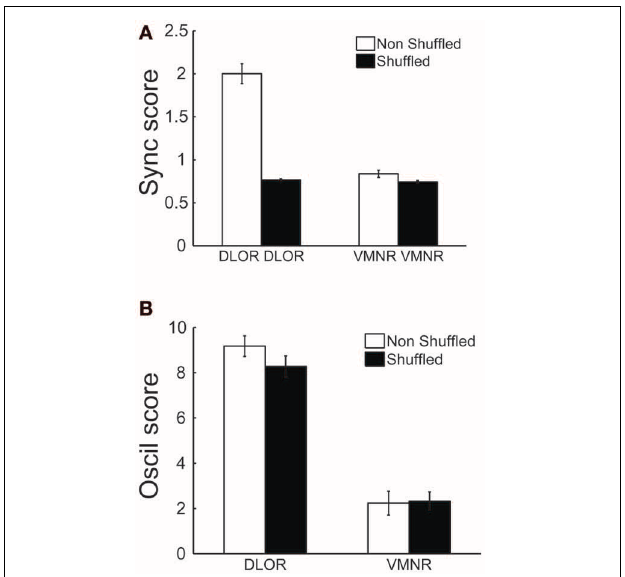
FIGURE 6 | Average values of synchronization ( sync score ) in the DLOR, but not average VMNR synchronization or oscillations scores in both STN domains, are affected by the shuffling procedures. (A) Synchronization ( Sync ) scores before (white) and after (black) shuffling, lines indicate standard error of the mean (SEM). (B) Oscillation ( Oscil ) scores before and after shuffling. Same conventions as in (A)